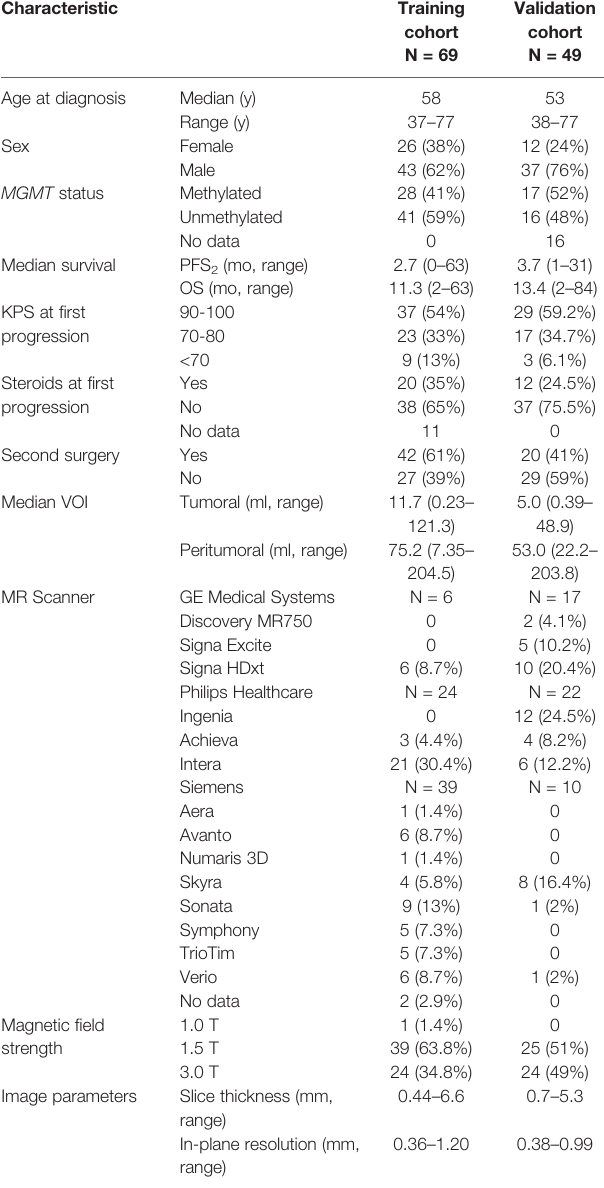
TABLE 1 | Clinical characteristics of studied patient cohorts (training and validation) and imaging protocol details.